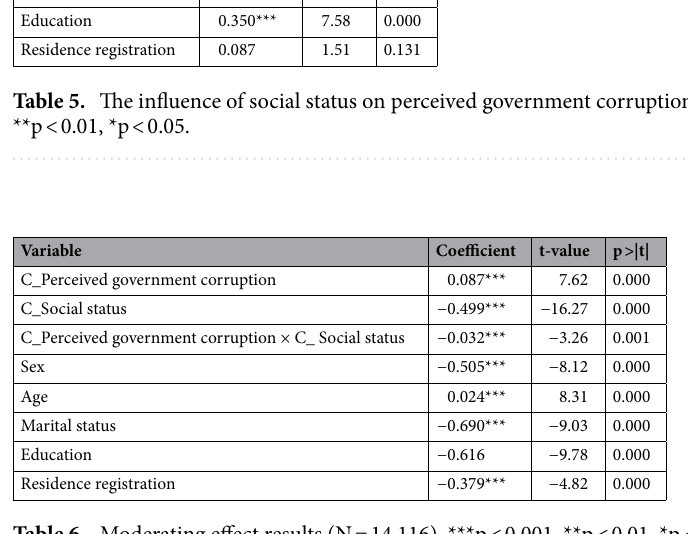
Table 6. Moderating effect results (N = 14,116). ***p < 0.001, **p < 0.01, *p < 0.05.